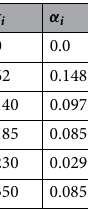
Table 1. Values of best fit timed intervention parameters for optimum match to